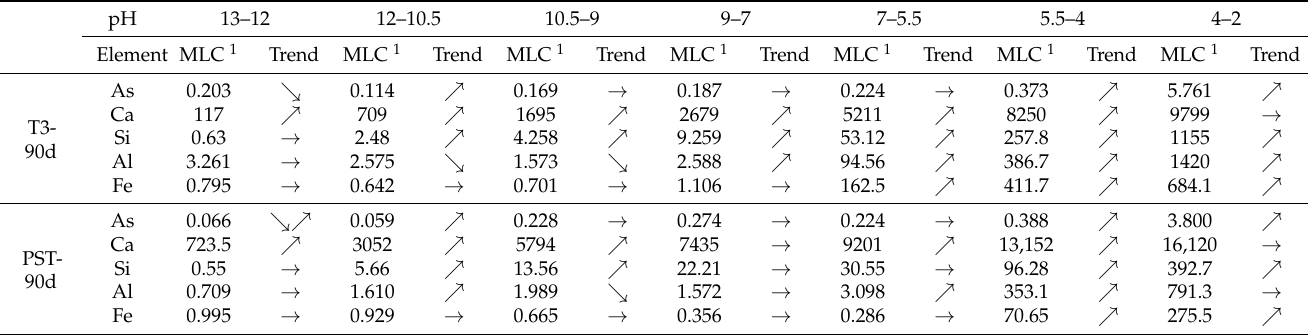
Table 5. Mean concentrations of leached As, Ca, Si, Al, and Fe and growth trend at continuous pH intervals for T3-90d and PST-90d after Method 1313 leaching